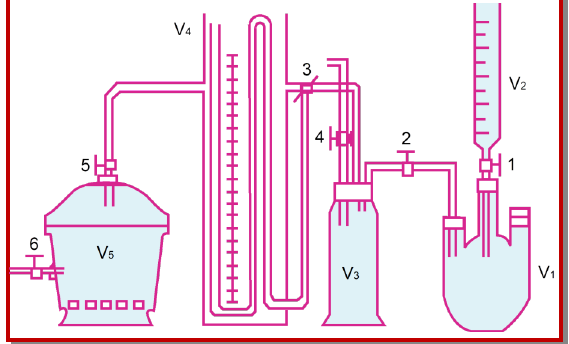
Figure 1: Apparatus for antitussive evaluation by sulfur dioxide gas production. V 1 : Saturated NaHSO 3 solution in 500 mL flask. V 2 : Concen- trated H 2 SO 4 in burette. V 3 : Gas cylinder. V 4 : Water manometer. V 5 :